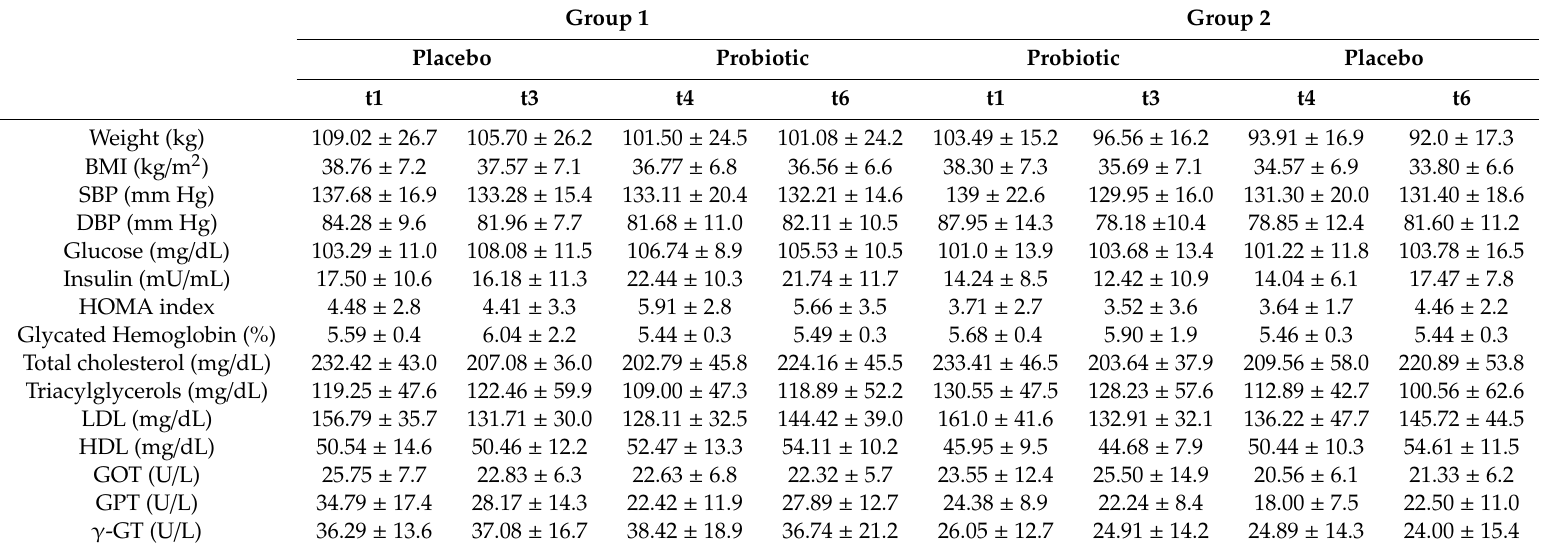
Table 1. Anthropometric and biochemical characteristics of the